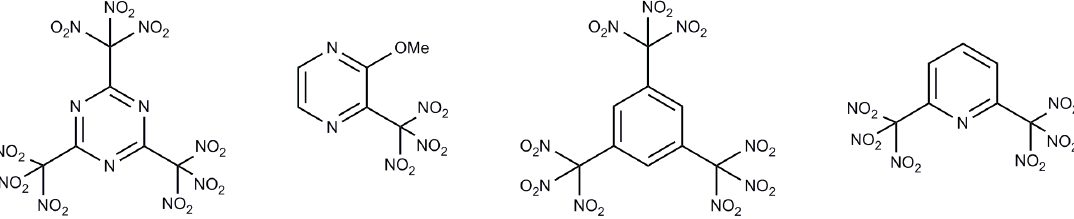
Figure 1. Representative trinitromethylazines/trinitromethylbenzenes and bis(trinitromethyl)- substituted